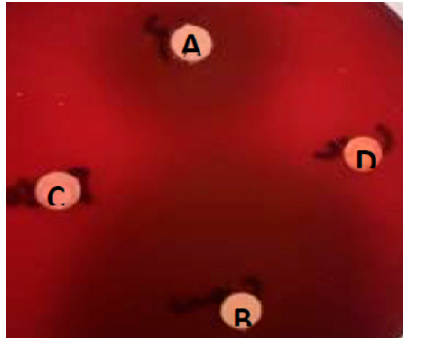
Fig. 2. Antimicrobial susceptibility tests (disc diffusion) of 1 mg/ml of A: capsaicin, B: ciprofloxacin, C: DMSO and D: curcumin against H. pylori